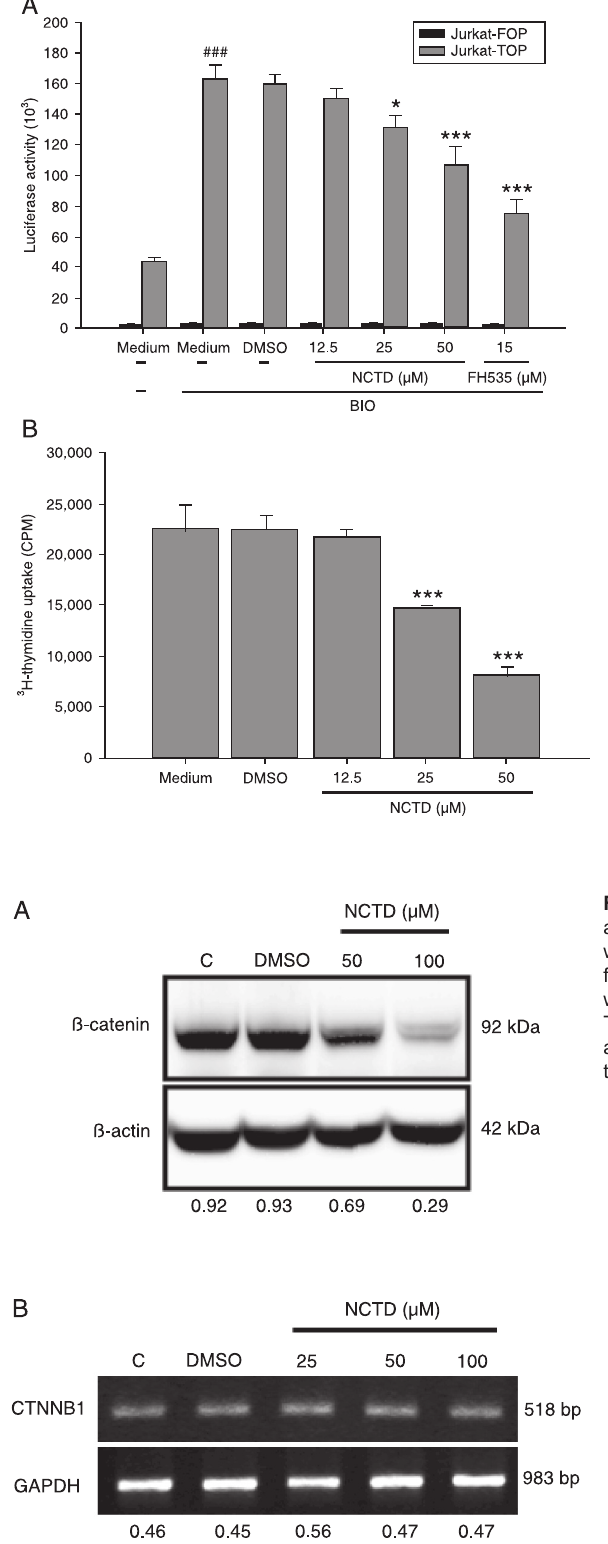
Figure 5. NCTD decreased luciferase activity in Jurkat-TOP cells induced by BIO and reduced Jurkat cell proliferation. Jurkat-TOP/ FOP cells (2 x 10 4 /well) were plated into a 96-well plate for 24 h and then stimulated with BIO (2.5 µM) in the presence of NCTD (25 and 50 μM) or a positive inhibitor (FH535, 15 µM) for 12 h. Total cell proteins were quantified and subjected to the luciferase assay. Each bar indicates the mean ± SD of three independent experiments. ### P < 0.001 vs cells treated with medium only. *P < 0.05, ***P < 0.001 vs cells treated with BIO and 0.025% DMSO (Student t -test). B , Jurkat cells were treated with 0.1% DMSO or NCTD (12.5, 25 and 50 μM) for 48 h. Cell proliferation was as- sayed based on the uptake of 3 H-thymidine. After 16 h of incuba- tion, the cells were harvested with an automatic harvester onto a glass fiber and the level of radioactivity was measured with a scintillation counter. NCTD = norcantharidin; BIO = (2’ Z ,3’ E )-6- bromoindirubin-3’-oxime. ***P < 0.001 vs cells treated with DMSO (Student t -test).